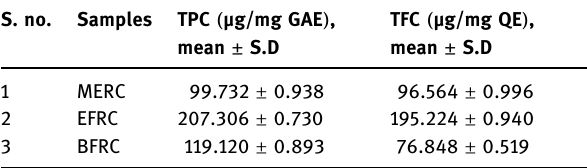
Table 2: TPC and TFC of R. cordifolia S. no. Samples TPC ( µg/mg GAE ) ,